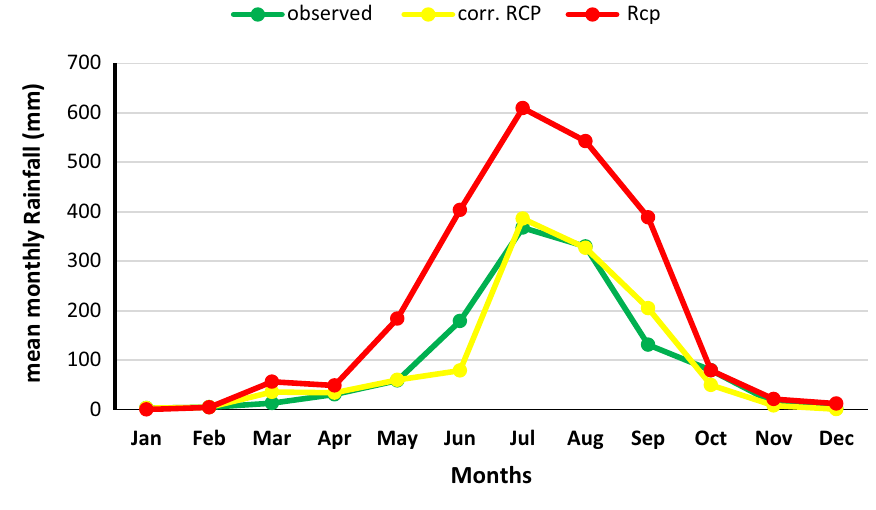
Fig. 2 Mean monthly areal rainfall